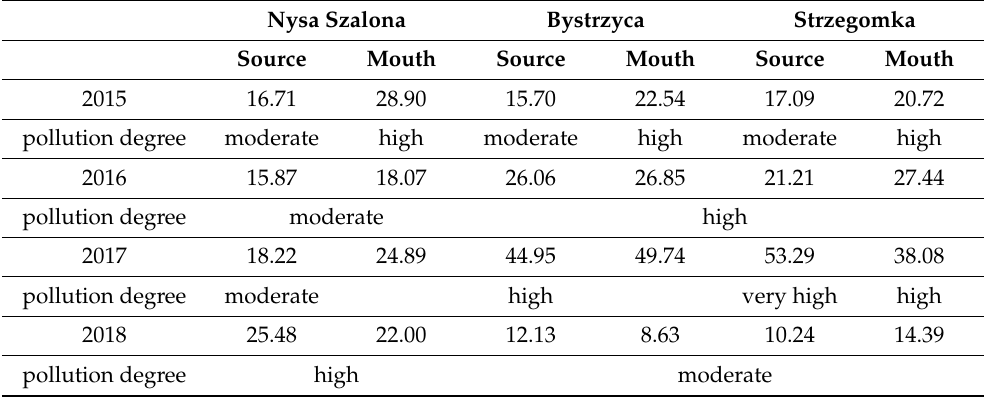
Table 12. Metal pollution index (MPI) of aquatic plants—mouth, sources in subsequent